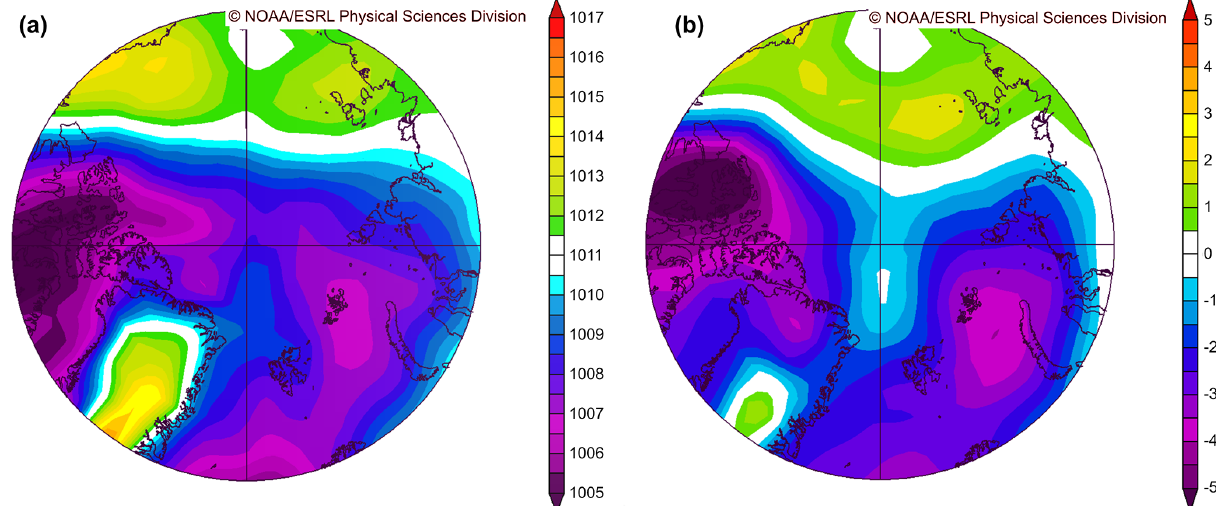
Figure 3. Contour plots of (a) mean sea-level pressure in hectopascals (hPa) and its (b) climatological anomaly (1981–2010) for the AO2018 measurement period. Image provided by the NOAA/ESRL Physical Sciences Division, Boulder, Colorado, USA, from their website at http://www.esrl.noaa.gov/psd/ (last access: 4 January 2021). Based on NCEP Reanalysis data (Kalnay et al.,